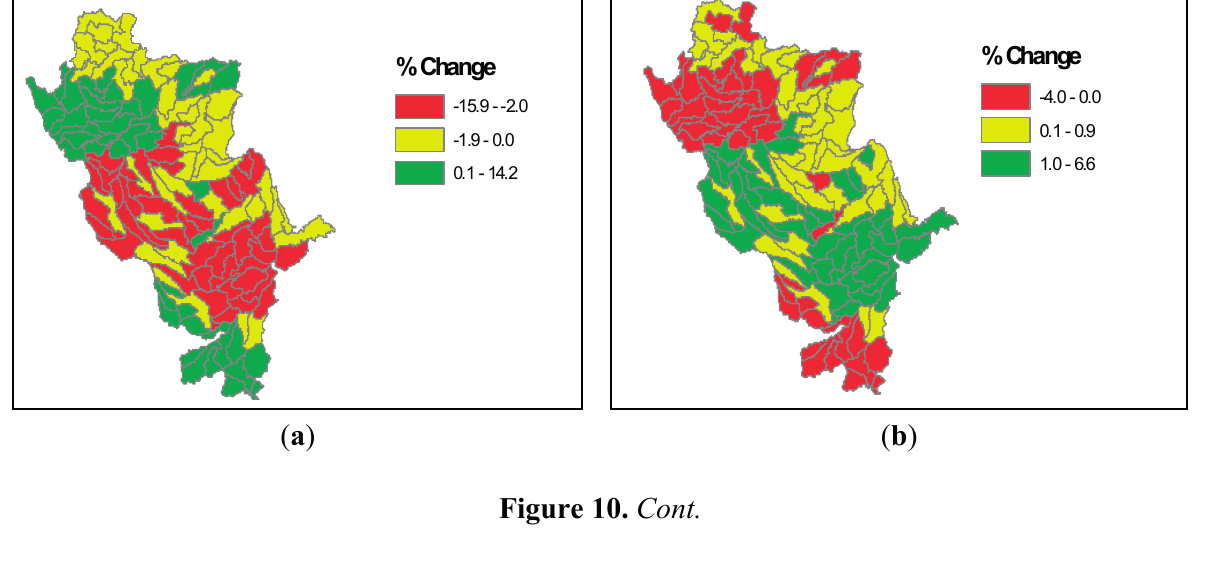
Figure 9. Spatial variation in the % change over baseline of: ( a ) Water Yield; ( b ) ET; ( c ) Sediment load; and ( d ) Total Nitrogen load from a 50% stover removal under no-till